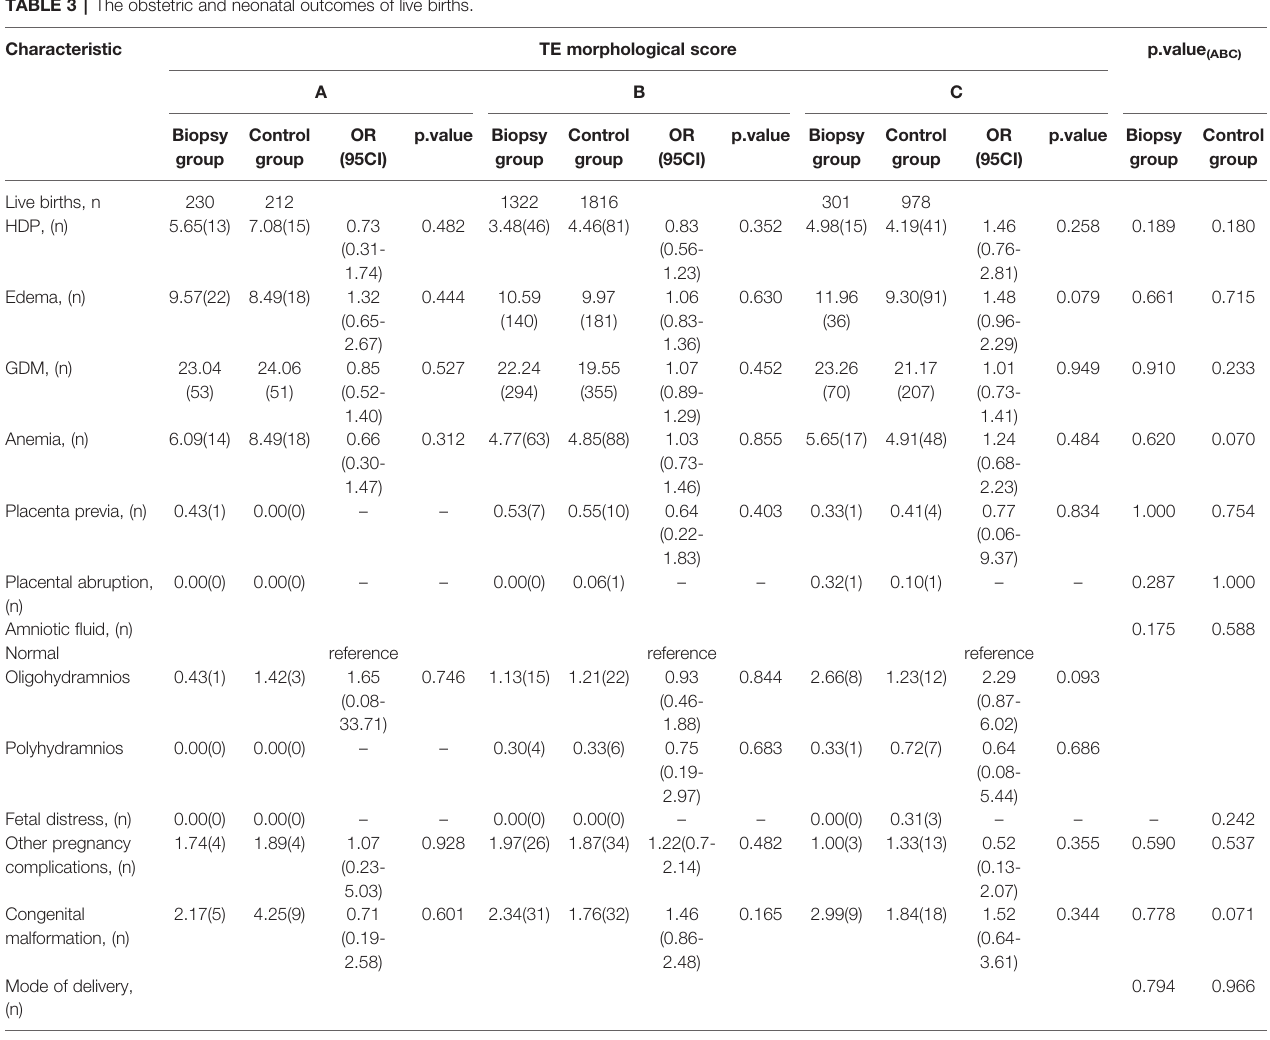
TABLE 3 | The obstetric and neonatal outcomes of live